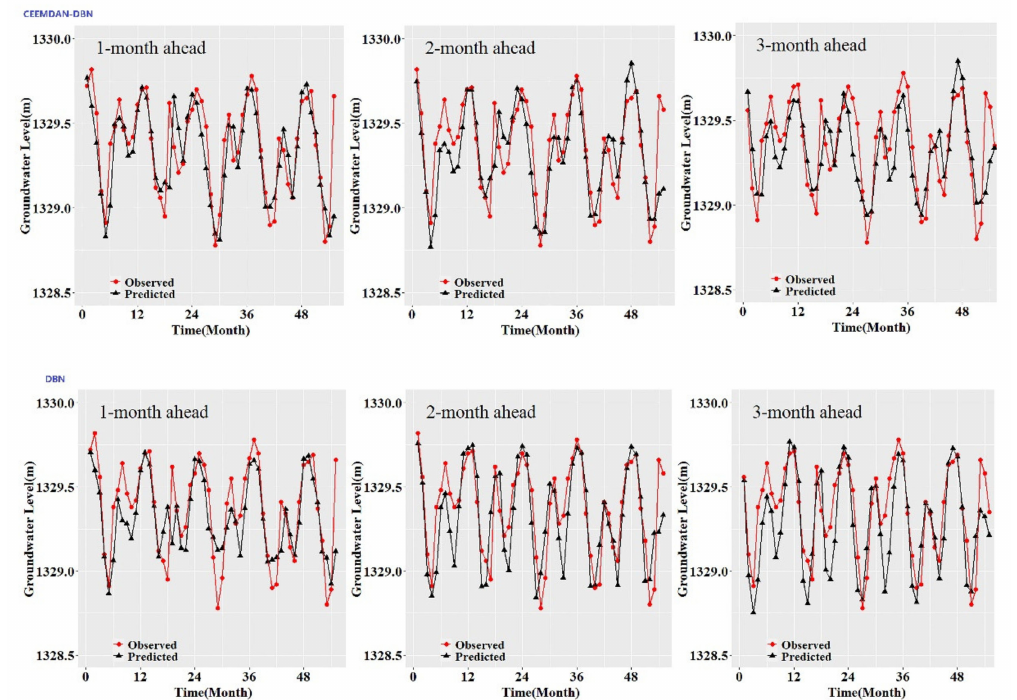
Figure 7. Observed vs. predicted groundwater level of Well III generated by the CEEMDAN-GA-DBN, CEEMDAN-DBN and DBN models for 1-, 2- and 3-month ahead forecast in the testing period.